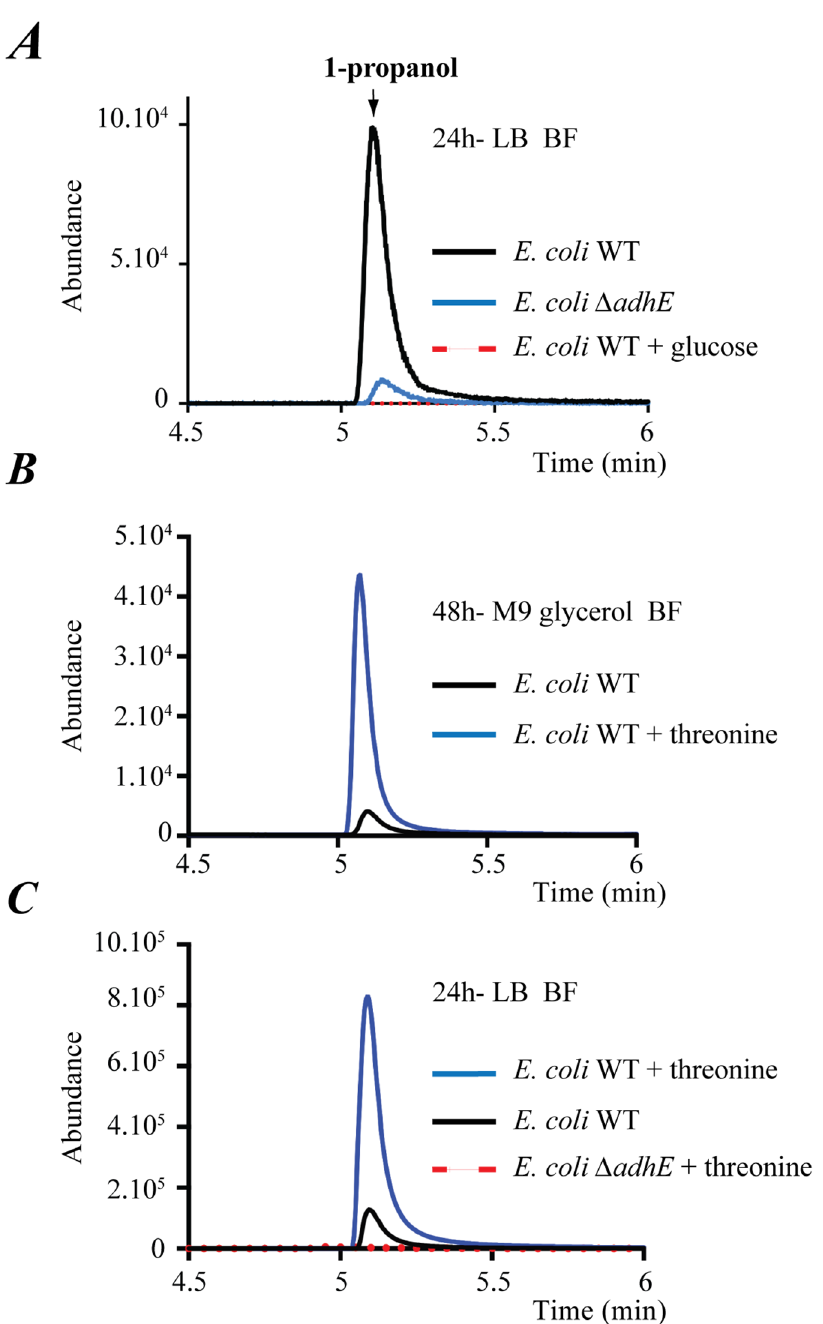
Fig 2. E . coli production of 1-propanol is AdhE-dependent and uses threonine as a precursor. ( A ) Comparison of HS-SPME/GC-MS analysisof 1-propanol emitted by E . coli WT and Δ adhE mutant biofilm grown for 24 h in LB medium under standard biofilm conditions(see also S2 Fig). ( B ) HS-SPME/GC-MS analysisof 1-propanol emitted from E . coli WT biofilms formed after 48 h in M9 glycerolminimalmedium with or without 0.4% threonine.( C ) HS-SPME/GC-MS analysisof 1-propanol emitted from E . coli WT and Δ adhE mutant biofilms formed in LB medium with or without 0.4% threonine.